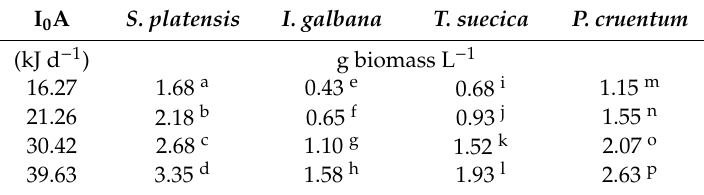
Table 2. Biomass accumulation: biomass concentration of microalgae at di ff erent light intensities supplied to continuous